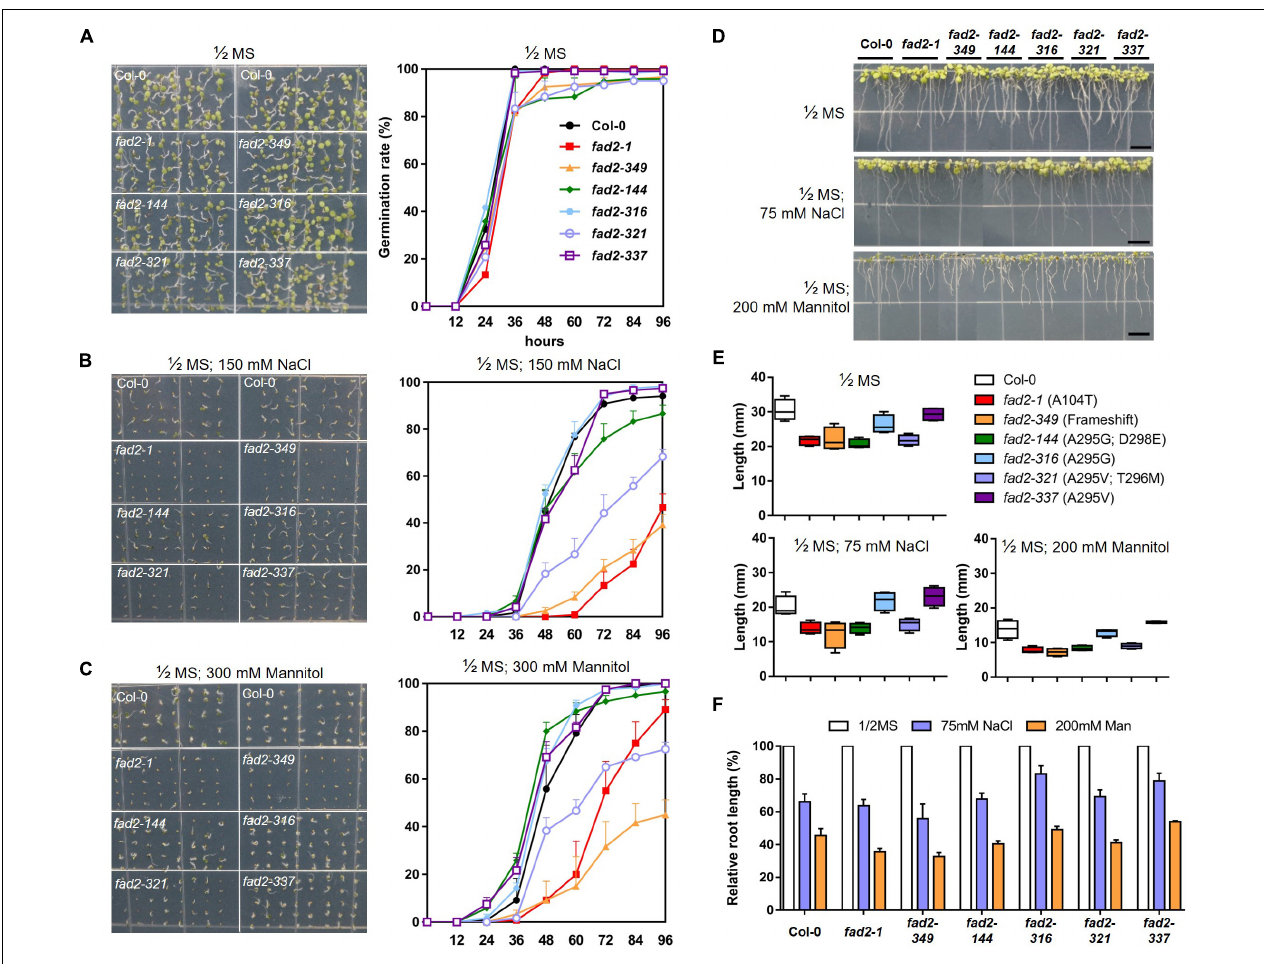
FIGURE 4 | Analyses of physiological responses of “attenuated” fad2 alleles. (A–C) Germination tests for fad2 alleles conducted in (A) , 1/2 MS, (B) , 1/2 MS; 150-mM NaCl, and (C) , 1/2 MS; 300-mM Mannitol condition to test whether increases in oleic acid content influence germination under both normal and stress conditions. The pictures were taken after 96 h of sowing. Germination rates were measured every 12 h in triplicate. (D–F) Analyses of root growth rates of fad2 alleles, whose seedlings had been grown for 4 days in 1/2 MS and then were transferred to both normal and stress conditions to allow root development for 5 days. The data presented in (D) , pictures taken to identify root lengths of 5-day-grown seedling under experimental conditions, (E) , graphs indicating the root lengths in different conditions, and (F) , a graph showing relative root lengths in 75-mM NaCl and 200-mM Mannitol when the root length in 1/2 MS was set to 100%. All values represent mean ± SD.